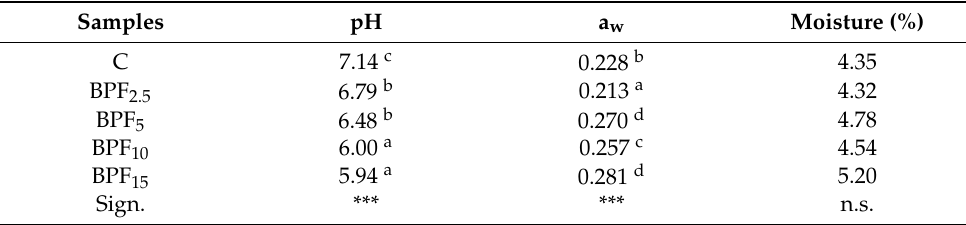
Table 4. Water activity (a w ), Moisture (%) and pH of the biscuit samples.